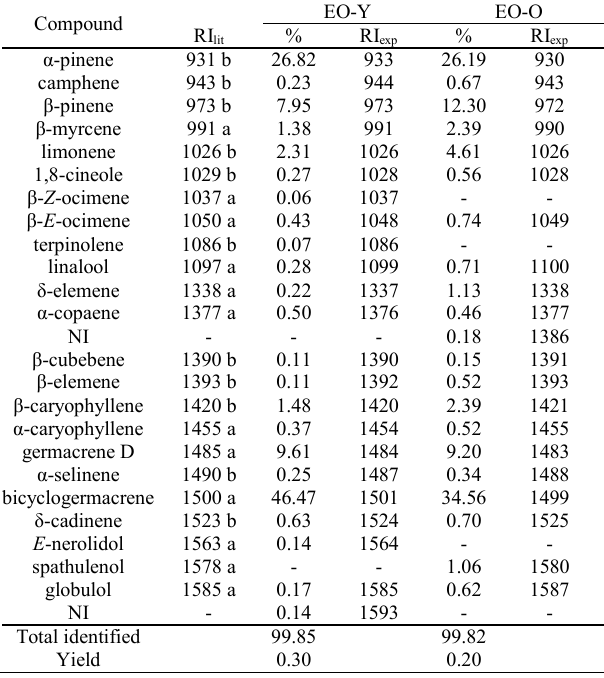
Table 1. Constituents of the young (EO-Y) and old leaf essential oil (EO-O) of Nectandra megapotamica. RI retention index from literature; RI index; NI = not identified; a = Adams (2001); b = databank NIST